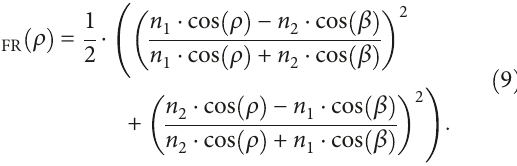
Figure 4: Model for the backsheet re fl ection. A normal incident beam of light is di ff use re fl ected from the backsheet with an angle ρ between − 90 ° and 90 ° . Fresnel back re fl ection on the top of the front glass fi nds